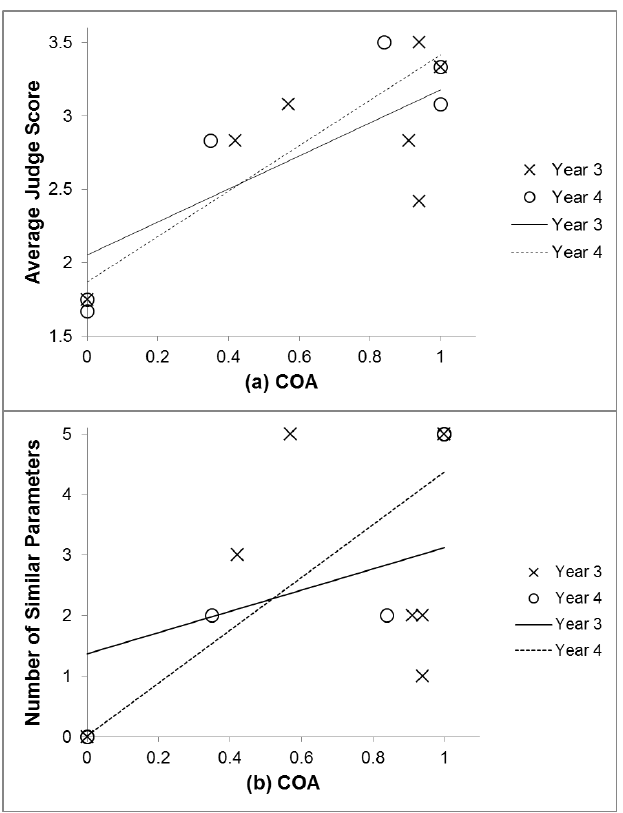
Figure 2. Relationships between COAs for mother and offspring pairs in years 3 and 4 after the offspring’s birth with (a) judge scores of similarity and (b) number of similar whistle parameters (total duration, maximum frequency, minimum frequency, initial frequency, and terminal frequency). Linear regression lines are included for each